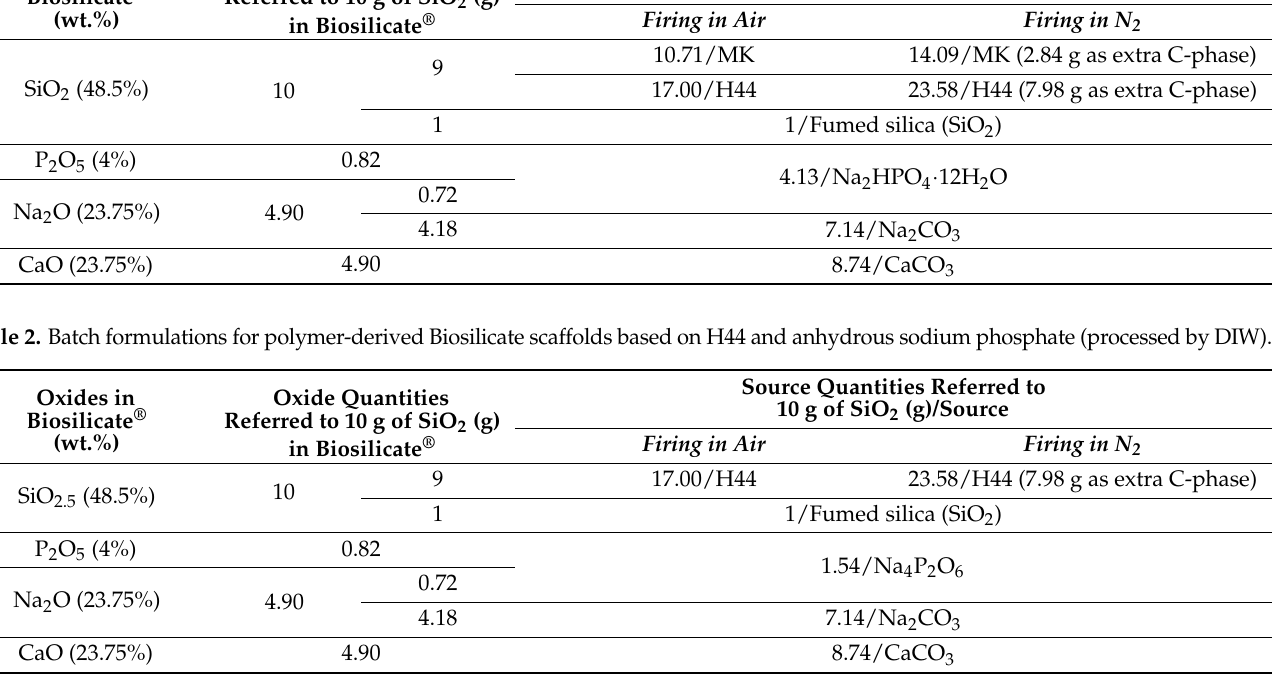
Table 1. Batch formulations for polymer-derived Biosilicate scaffolds, by DIW, based on both MK and H44 polymers. Oxides in Biosilicate ®